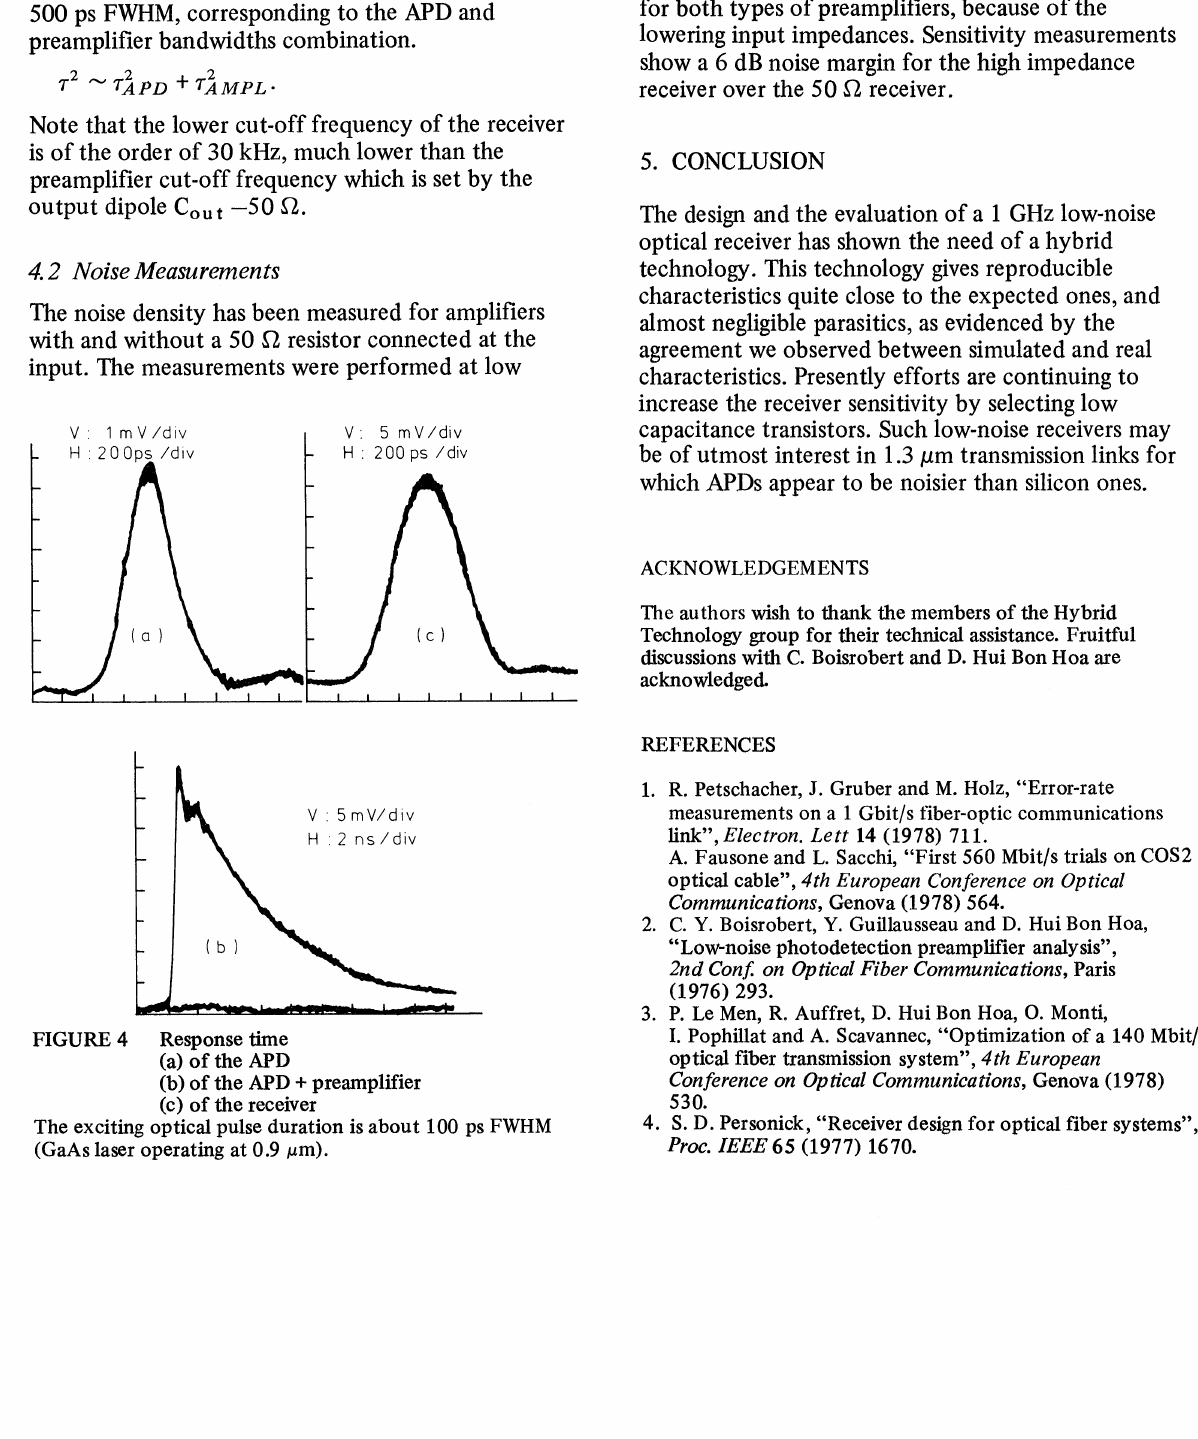
FIGURE 4 Response time (a) of the APD (b) of the APD + preamplifier (c) of the receiver The exciting optical pulse duration is about 100 ps FWHM (GaAs laser operating at 0.9